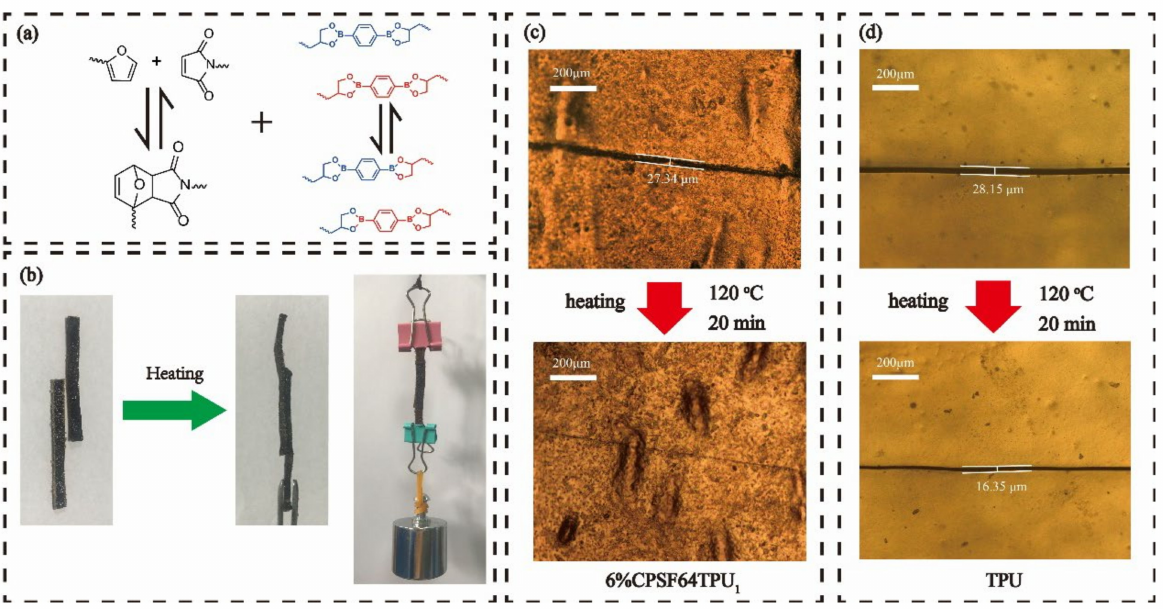
Figure 11. ( a ) Schematic representation of DA reaction (right) and the transesterification reaction of boronic ester link- ages(right) ( b ) optical images of welding behaviors of 6%CPSFTPU 1 sample, optical microscope images of the and TPU fracture surface before and after self-healing: ( c ) for 6%CPSFTPU 1 and ( d ) for